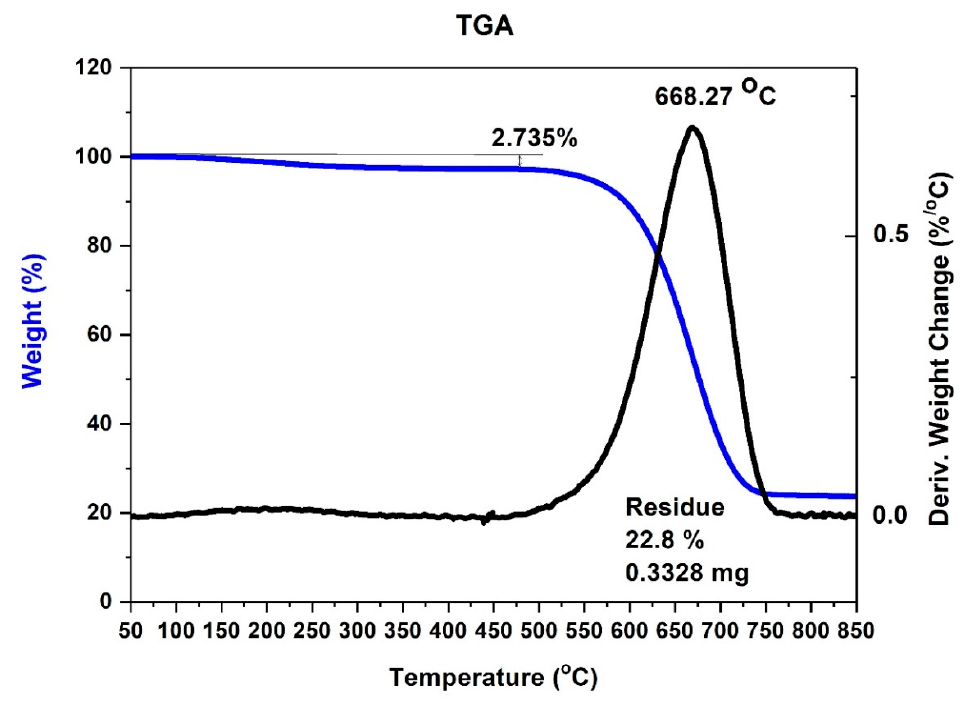
Figure 8. TGA of ferromagnetic MWCNTs—sample no. 4 (optimum flow velocity).